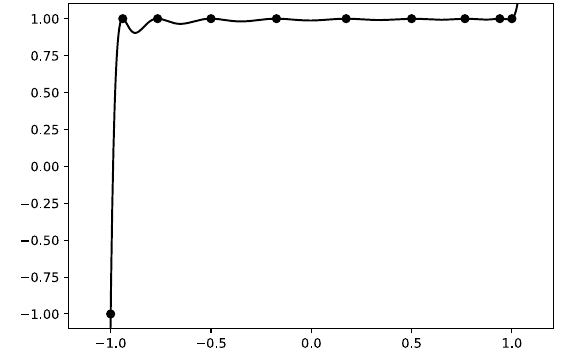
FIG. 4. Example of the Hermite interpolating polynomial for an n -qubit controlled phase gate for n = 9. As in Sec. III, x coordinates of points are eigenvalues of cos { (π/ 2 ) [ 1 − (cid:9) ( 1 / n ) Z j ] } , while y coordinates are the phases controlled on j them, so the leftmost point corresponds to all qubits being 1, in which case the − 1 phase is